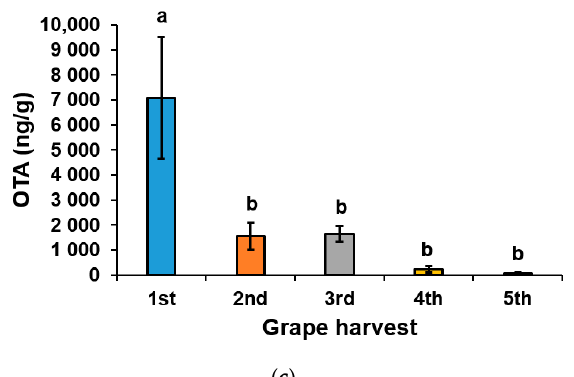
Figure 1. Disease development in freshly harvested fruits at different time points following the inoculation of “Superior” grape berries by A. carbonarius . The grape berries were inoculated immediately after harvest. ( a ) Histogram showing the decay area of the rotten tissue on infected grape berries. ( b ) GLA and ( c ) OTA accumulations were measured in infected fruits at day 7 post-inoculation. Error bars represent standard error of three independent biological replicates. Different letters above the columns indicate statistically significant differences at p < 0.05, as determined using the Tukey’s honest significant difference test.